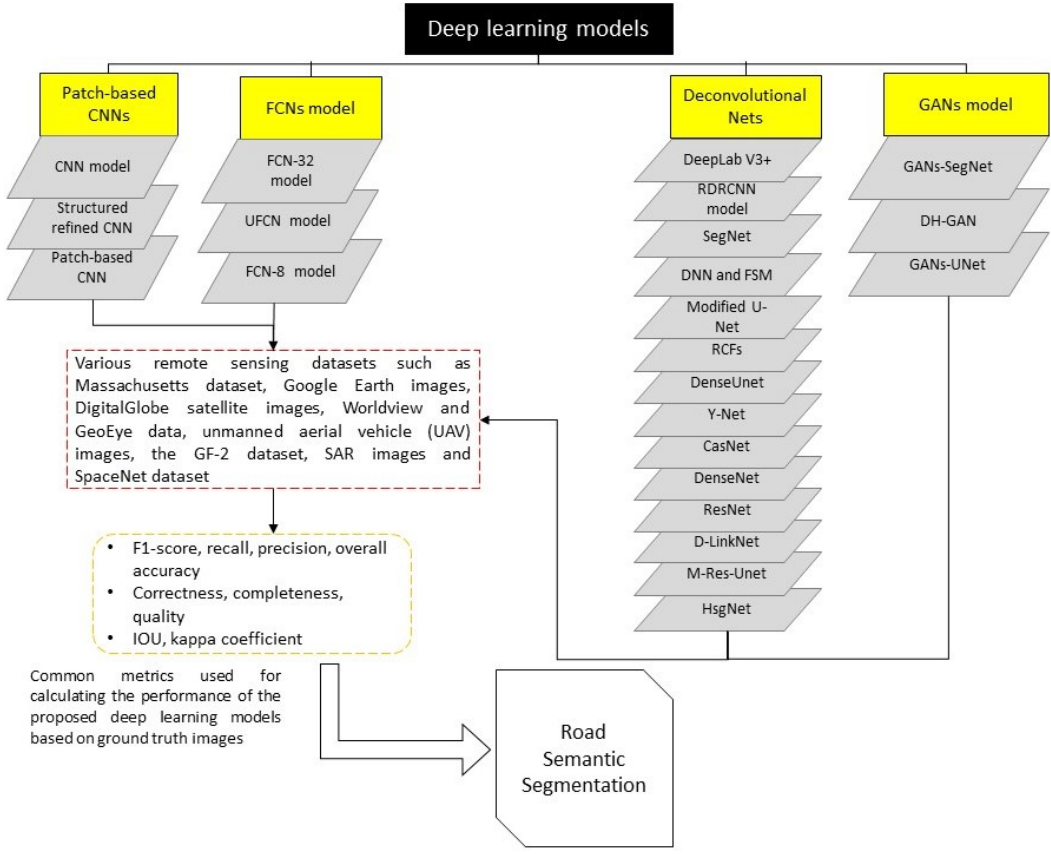
Figure 2. Road semantic segmentation using different deep learning models from remote sensing datasets.